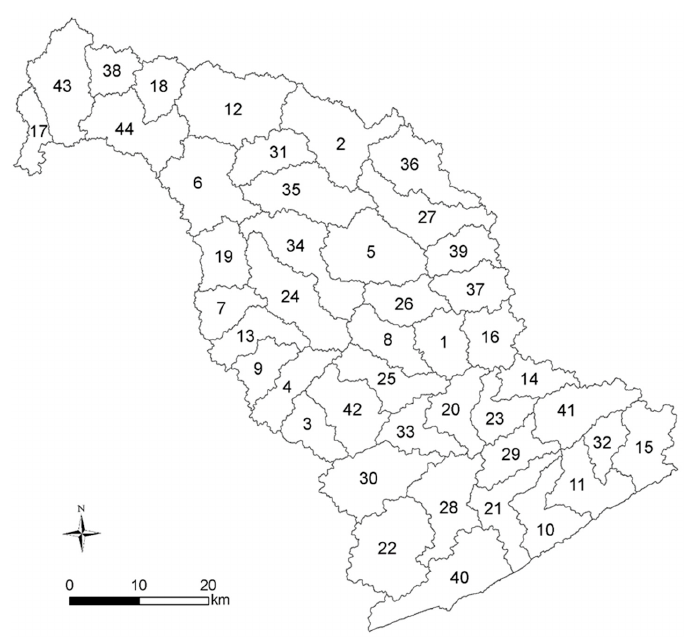
Figure A1. Subwatersheds of the NFKR watershed.